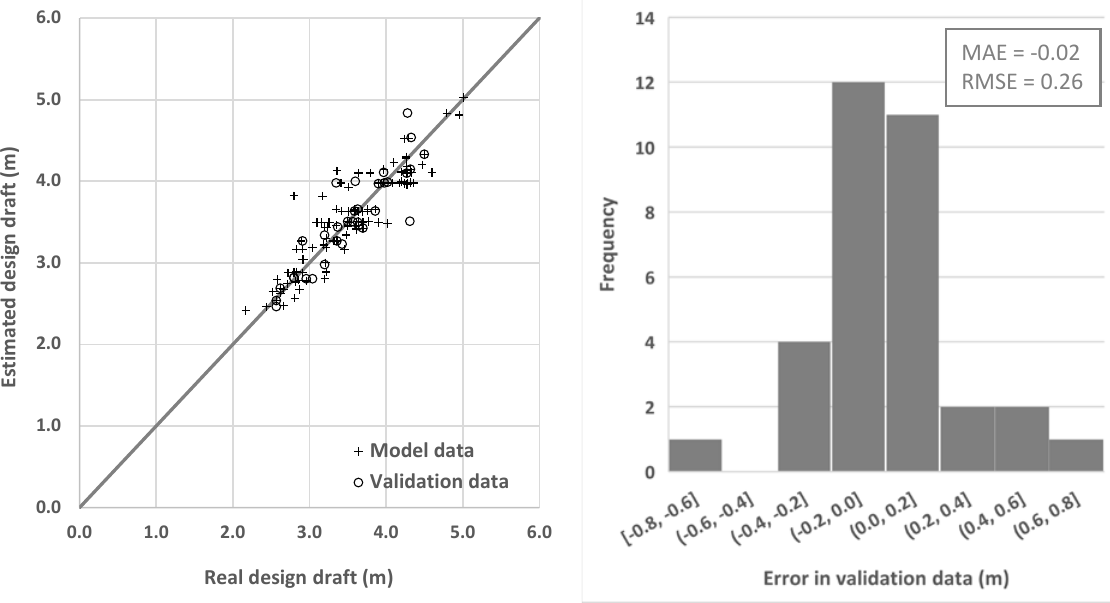
Figure 10. Design draft model validation and histogram of error terms